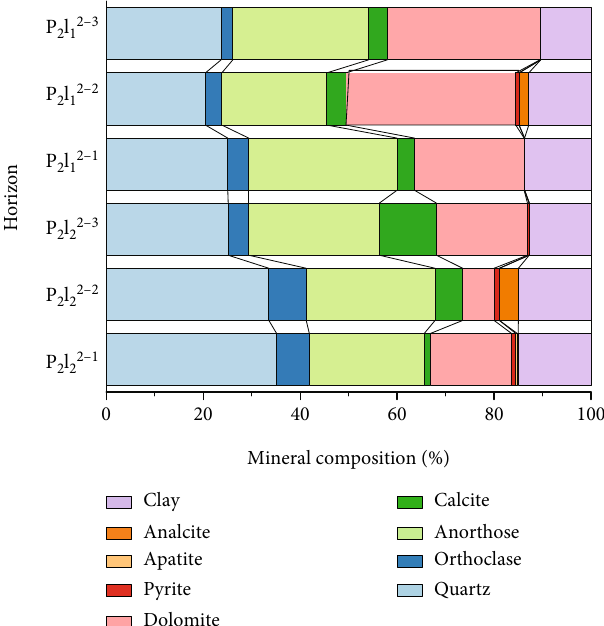
Figure 1: Mineral composition in di ff erent horizons.